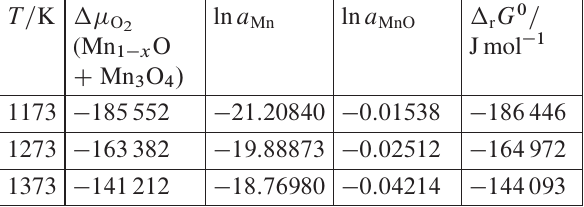
Figure 7. Results of “third-law” analysis of Gibbs energy of formation of Mn 3 O 4 from MnO derived from oxygen potential measurements, with and without correction for the activity of MnO. The filled symbols represent values without correction and open symbols values with correc-